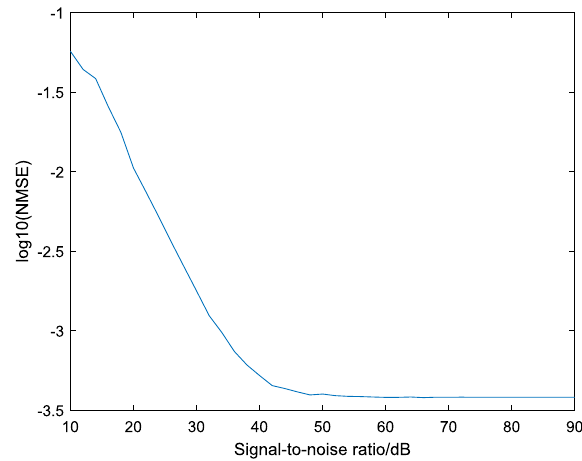
Fig. 6 Calculation of NMSE with varying SNR